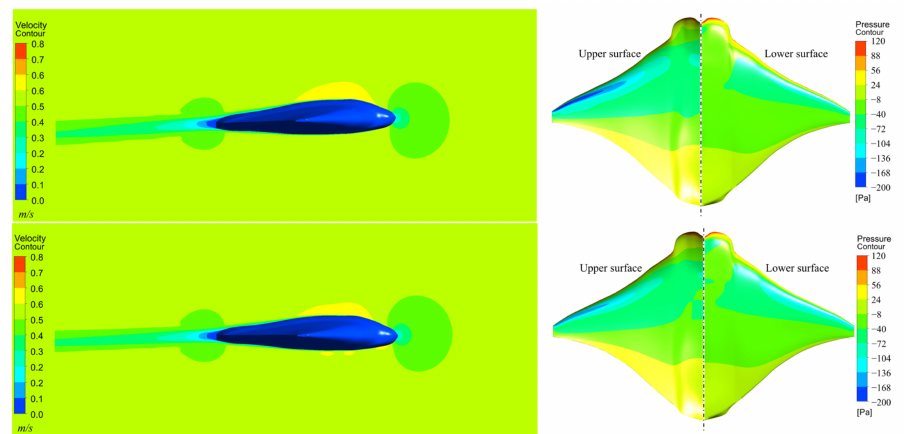
Figure 8. Longitudinal symmetry plane velocity distribution and manta ray surface pressure distri- bution during single gliding at α = 0 ◦ ( up ) and α = − 2 ◦ ( down ).